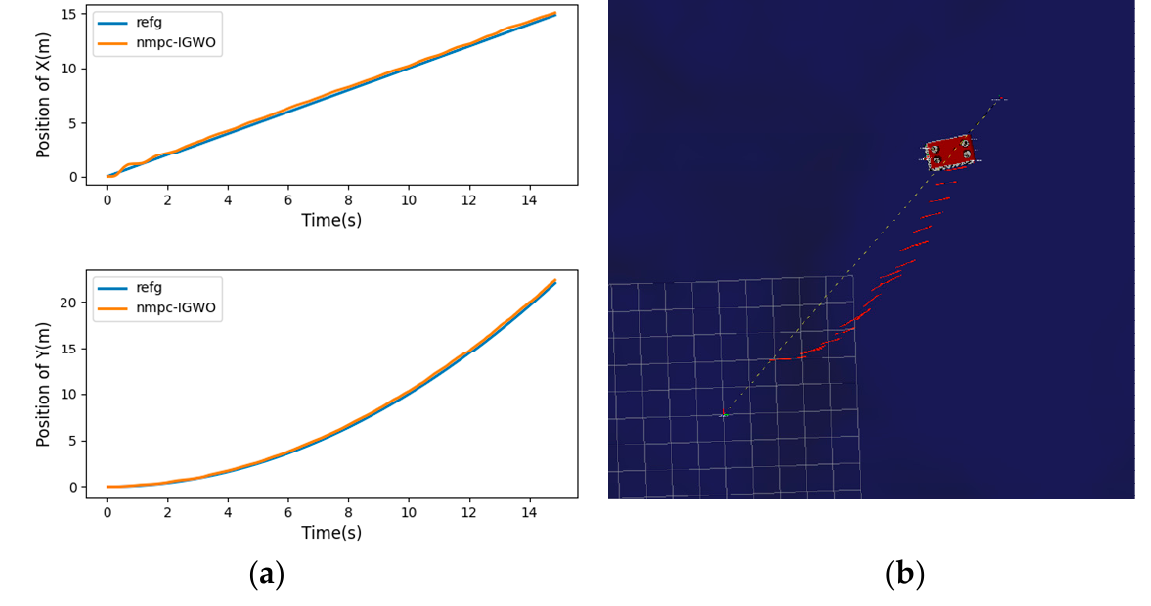
Figure 7. case I trajectory tracking effect: ( a ) case I x/y state tracking effect; ( b ) case I XOY plane tracking effect.